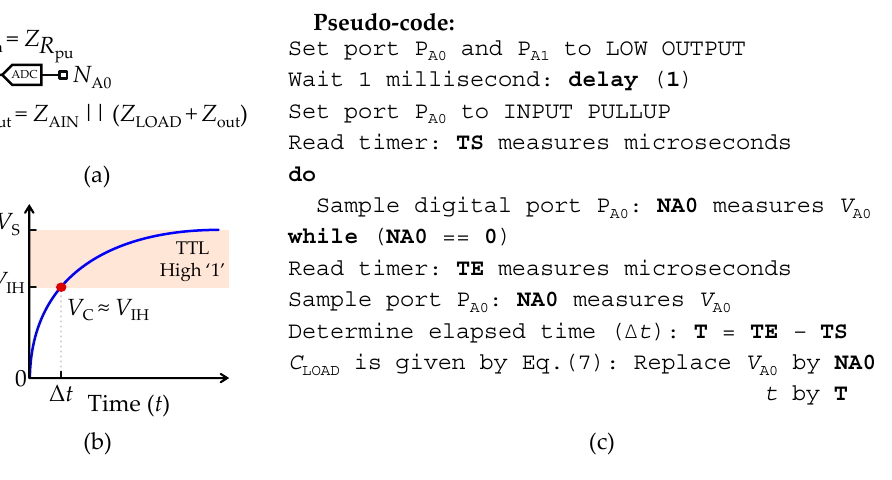
Figure 4. Set-up for recording a pure load capacitance ( C LOAD ) through the transient acquisition mode. ( a ) Impedance representation of the reduced equivalent circuit. ( b ) Illustration of the step response in voltage measured at the input terminal of C LOAD . V IH is defined in Table 1. ( c ) Pseudo- code used to implement the transient acquisition mode.